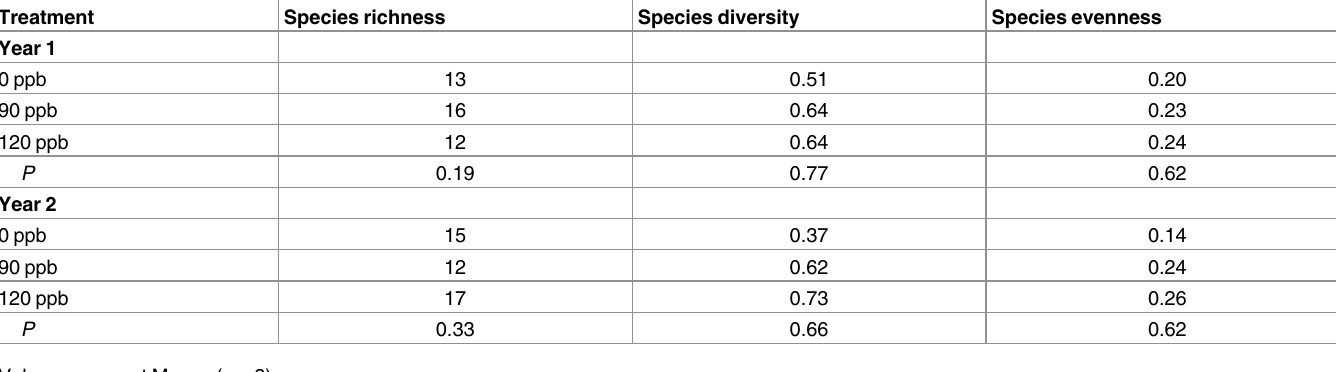
Table 2. Means and statistics from analysis of varianceof species richness ( S ), species diversity (Shannon-Weaver index, H´) and species even- ness ( H ´/log e ( S )) for plant communities established from different historic exposure regimens.